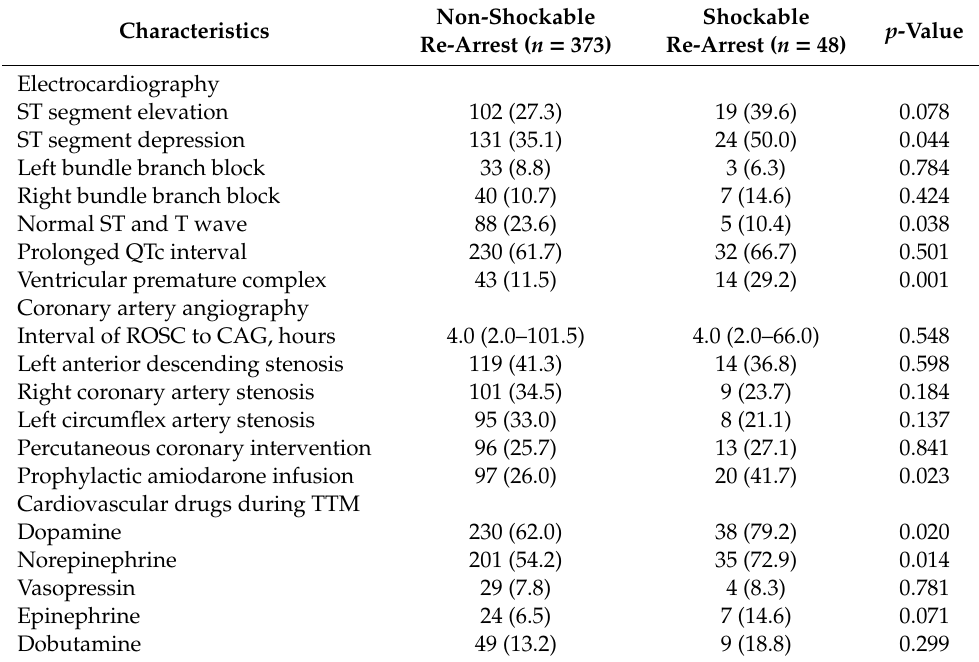
Table 3. Cardiovascular management during post-cardiac arrest care between patients with non-shockable re-arrest and shockable